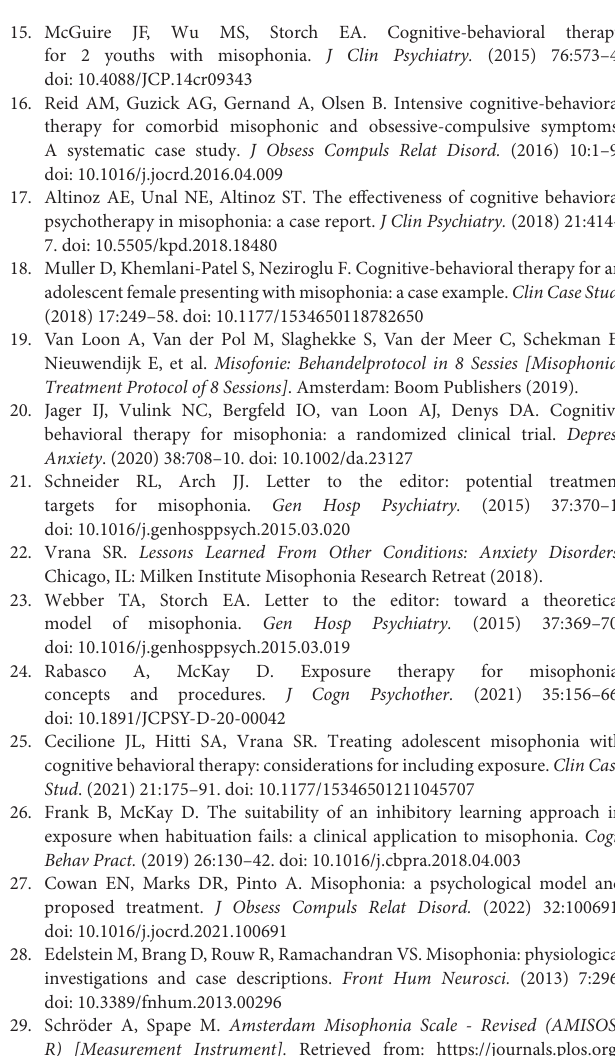
Supplementary Video 1 | Example of stimulus manipulation: audio fragment DJ sniffing. Supplementary Video 2 | Example of counterconditioning: video fragment Baby sniffing. Supplementary Video 3 | Example of counterconditioning: video fragment Bird